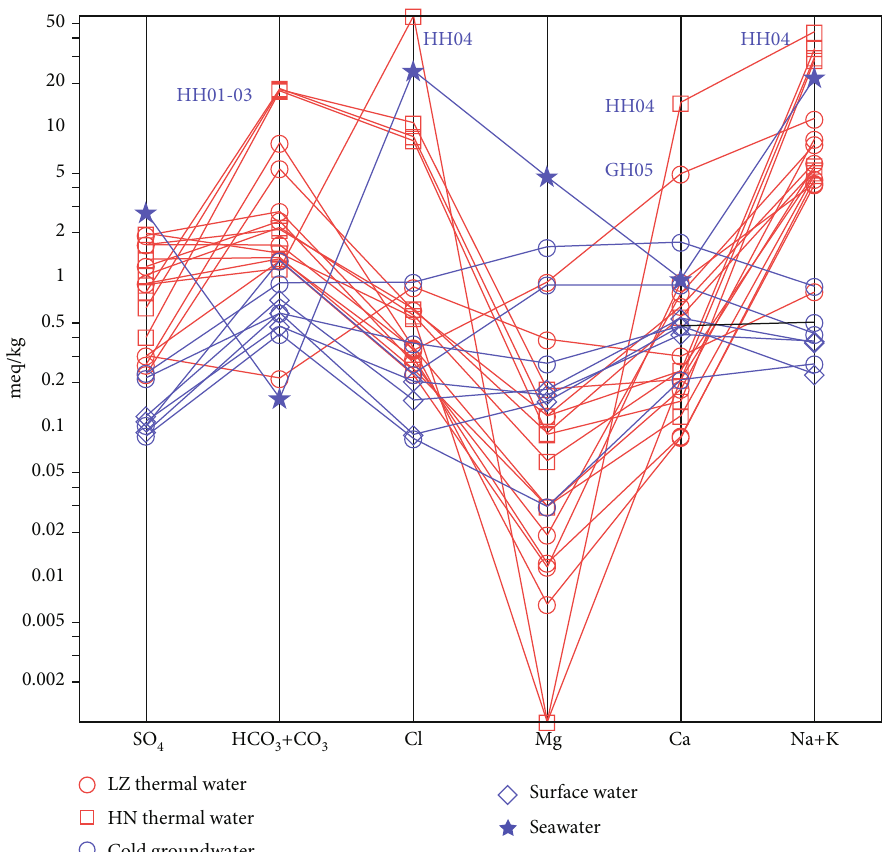
Figure 3: Schoeller diagram showing main ions constituents of the water